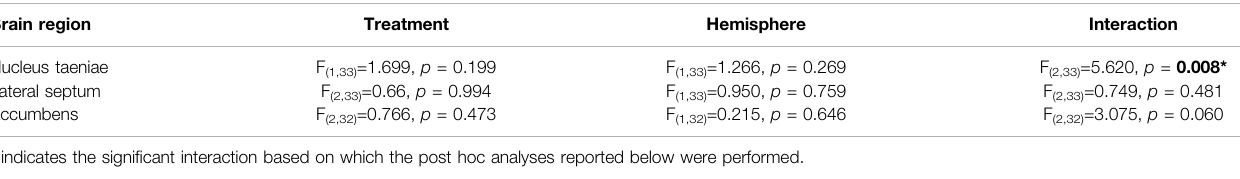
TABLE 1 | Summary of the statistical results of brain